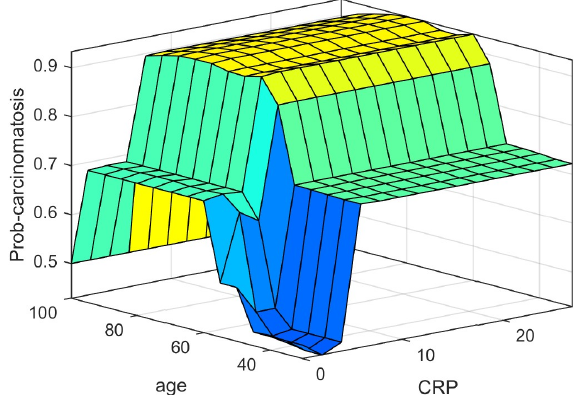
Figure 13. Prob-carcinomatosis variation with Age and CRP.